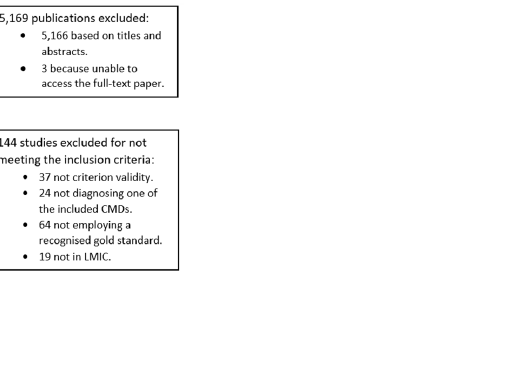
Fig 2. Study selection flow